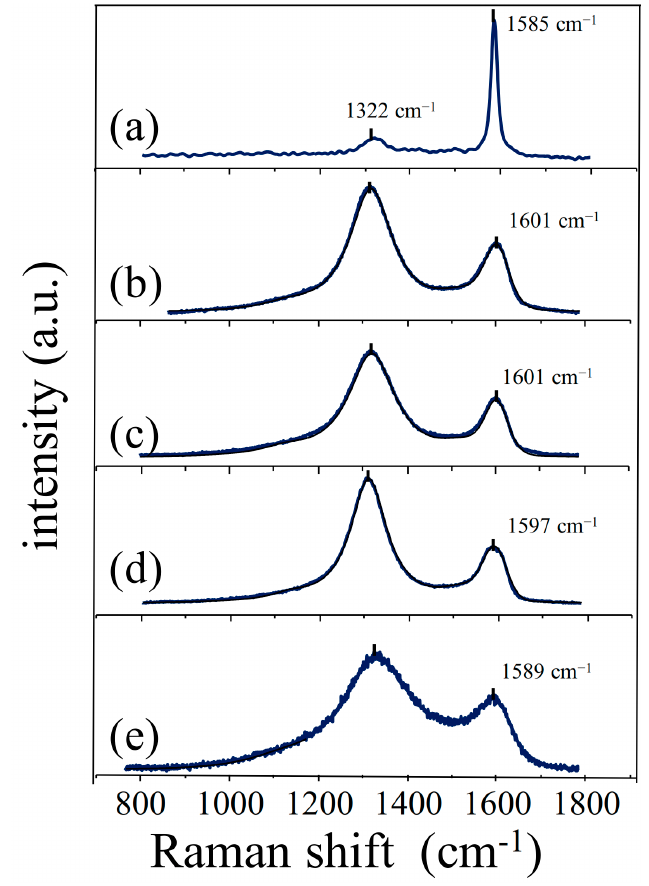
Figure 5. Raman spectra of ( a ) graphite; ( b ) CRGO; ( c ) hTRGO; ( d ) ERGO; and ( e ) TRGO.